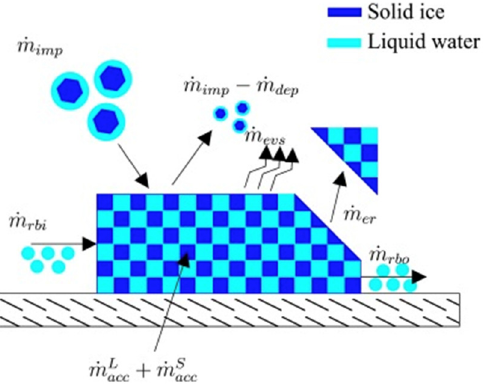
Figure 7. Schematic of parameters contributing to the mass conservation (obtained from [96]). . m imp , can be used to describe the impinging water Note that the impinging mass rate, While the melting ratio, 𝜂 (cid:3040) , can be measured, the sticking efficiency, 𝜀 (cid:3046) , the fraction . . L S m m mass rate, , and the impinging ice crystal mass rate, , as follows: of impinging mass that adheres to a surface [99], is left unknown. Trontin and Viledieu imp imp [96] developed an empirical model based on the experimental results from Currie et al. [100]. They measured the sticking efficiency at the stagnation point of a crowned cylinder over a small value range of the melting ratio at Mach 0.25 and 0.4.